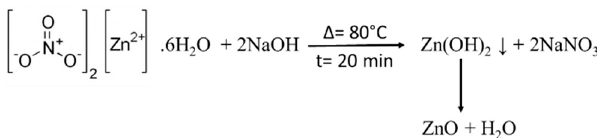
Figure B1. XRD spectrum of the powdered ZnO NP synthesized at 80 °C and non-annealed. The red circles show broad and peak intensities, in relation to amorphous ZnO NP.